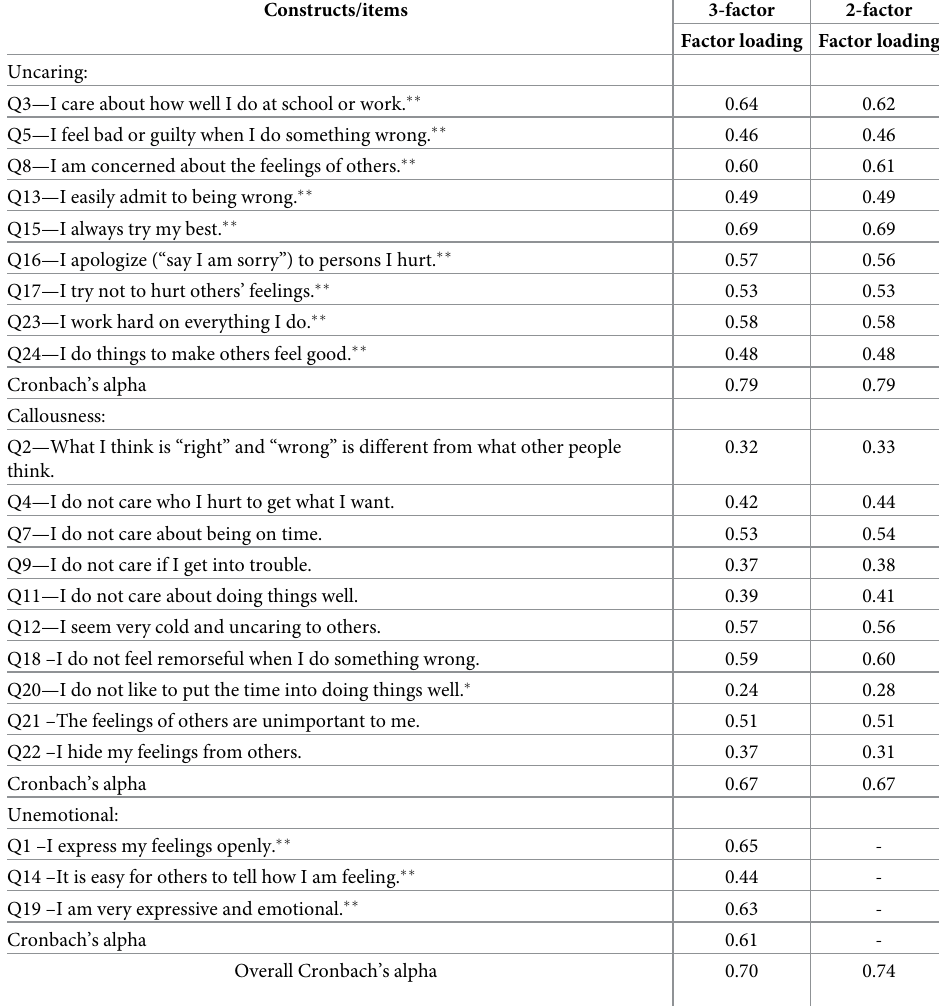
Table 2. Factor loading, Cronbach’s alpha value for 3-factor EFA and 2-factor EFA final models. Constructs/items 3-factor 2-factor Factor loading Factor